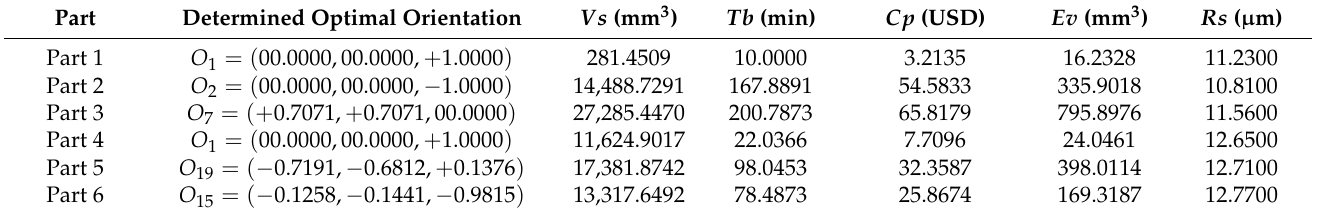
Table 1. Determined optimal orientations for the six parts and corresponding predicted factor values.